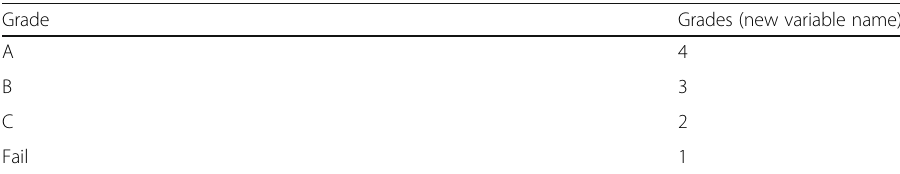
Table 4 Encoding grades